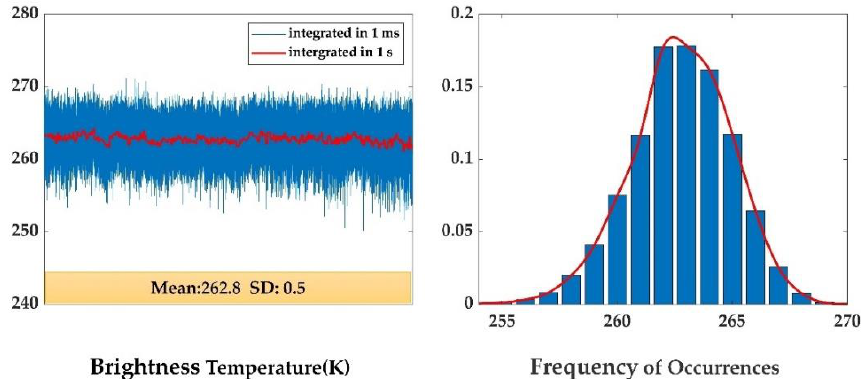
Figure 11. UAV in rotor rotation state measurement of the matching load TB ( left ) and its frequency distribution histogram ( right ).